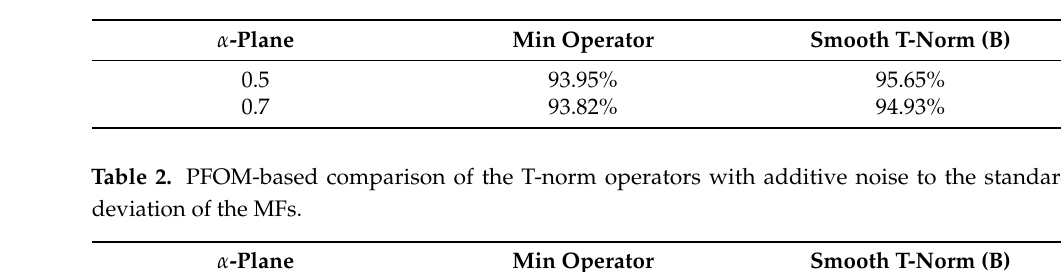
Table 1. PFOM-based comparison of the T-norm operators with additive noise to the mean of the MFs.